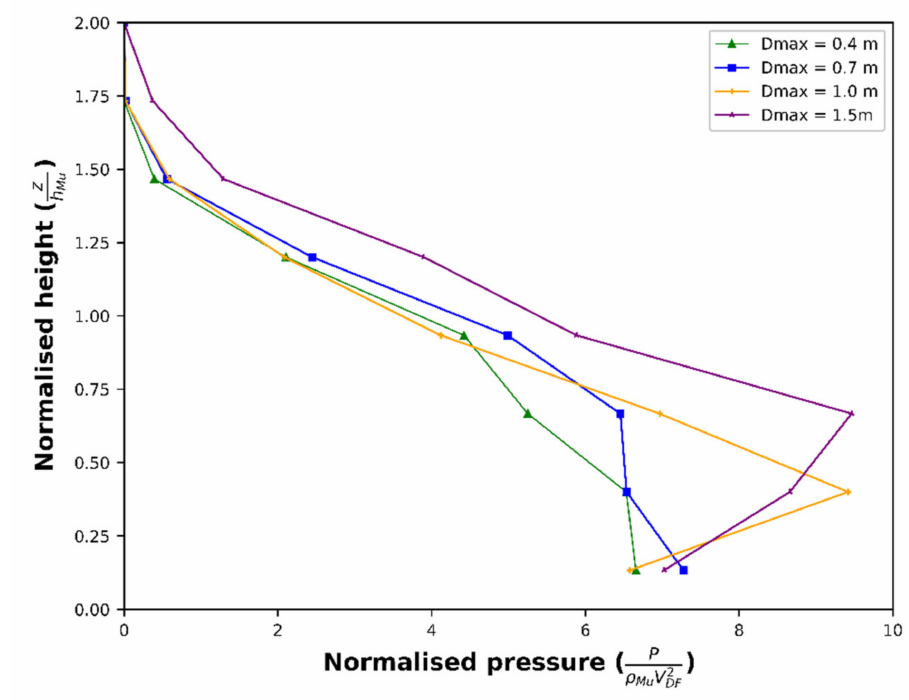
Figure 4. Normalized stress (cid:101) p induced by DF versus normalized flow height on the pillar, for four different d max .